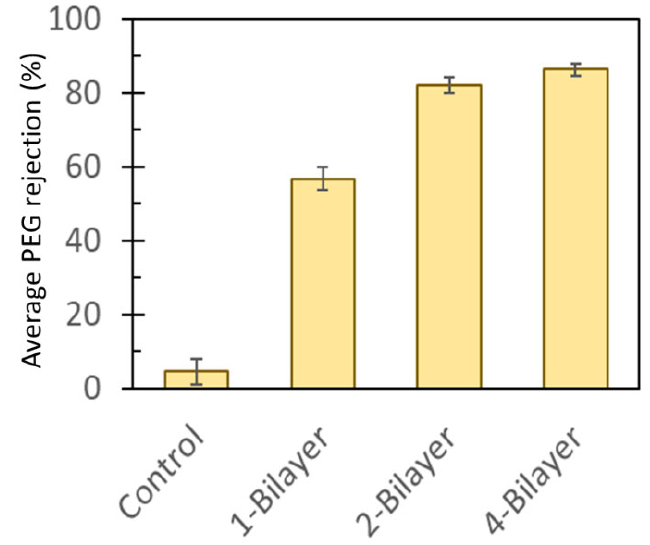
Figure 8. Comparison of the selectivity of 20 KD polyethylene glycol (PEG) of pristine CA membrane (control, 0.45 µ m pore size) with that of GO–PEI surface-modified CA membranes.